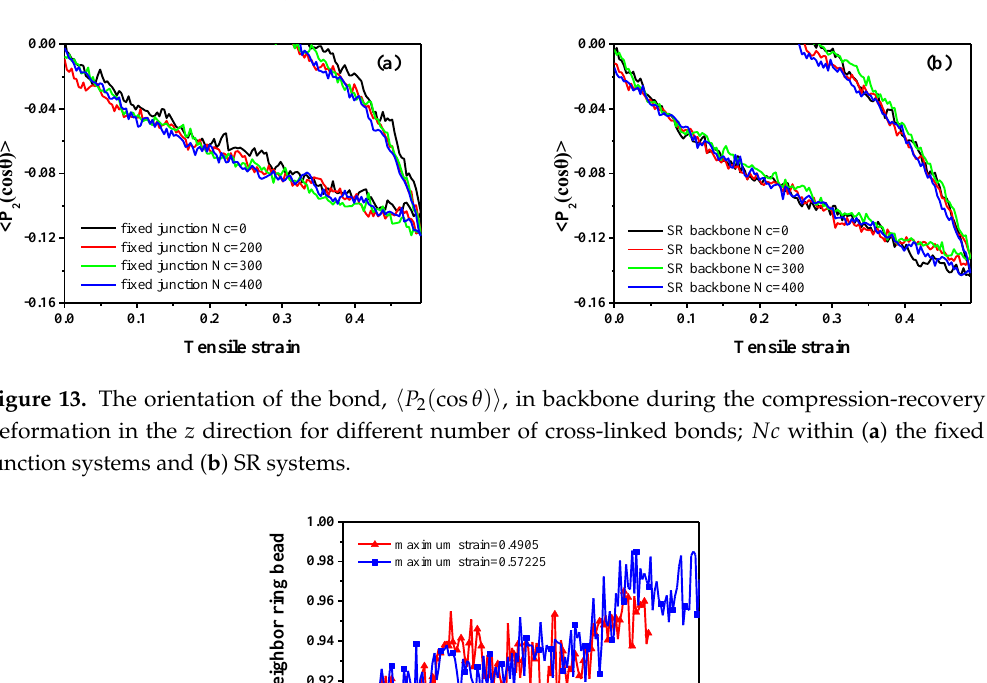
E , and bond stretching non-bonding